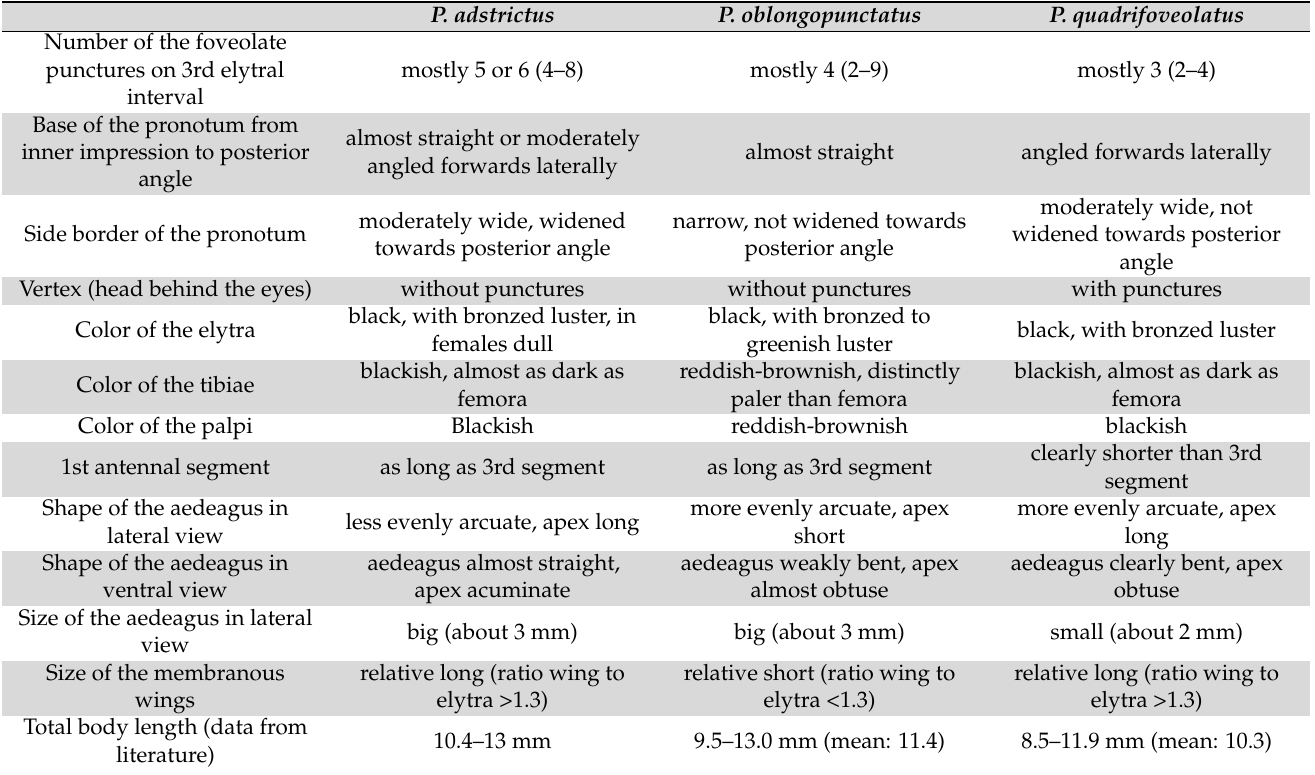
Figure 4. Comparison of the pronota of Pterostichus adstrictus , Kaunertal/Austria ( a ), P. oblongopunctatus , Tainach/Austria ( b ) and P. quadrifoveolatus , Vracov/Czech Republic ( c ), scale bar = 1 mm. The arrows indicate the widened ( a ), not widened ( b ) lateral edge of the pronotum and the angled base of the pronotum ( c ). Table 2. Synoptic key for the three European Pterostichus species of the subgenus Bothriopterus . The determination characters are compiled from own new data and the literature [27–29].